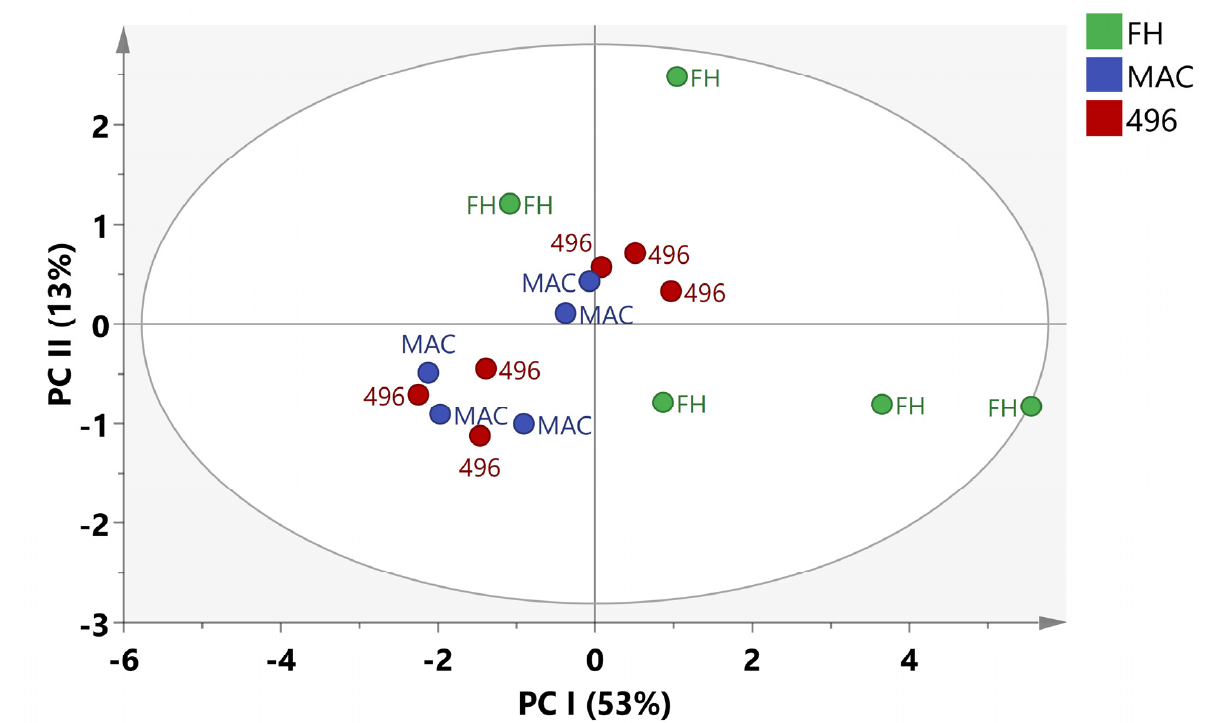
Figure 3. PCA score plot of cotton varieties .